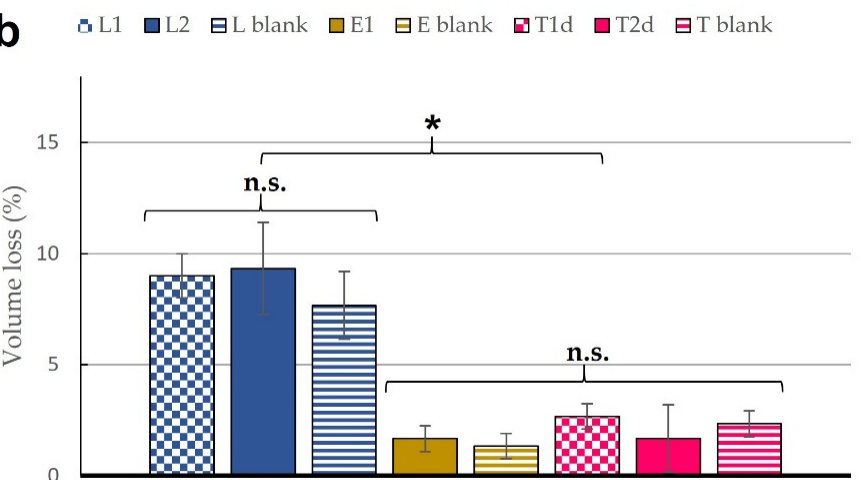
Figure 1. ( a ) Size change after extrusion through 100 nm membrane; ( b ) Volume loss after extrusion through 100 nm membrane (9 passages). All results are expressed as mean ± SD ( n = 3). * means statistically significant differences ( p < 0.05), n.s. means no statistically significant differences ( p > 0.05) using one-way ANOVA followed by Tukey’s multiple comparison